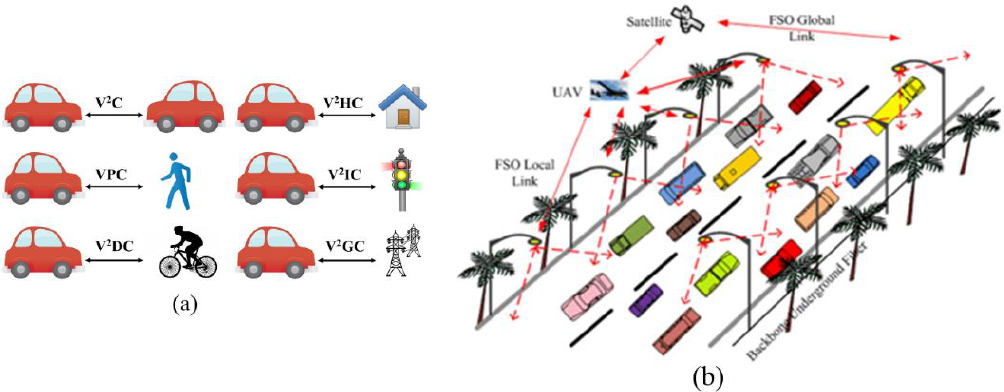
Figure 35. ( a ) Vehicle–VLC communication scenarios; and ( b ) continuous data connectivity via street lights.